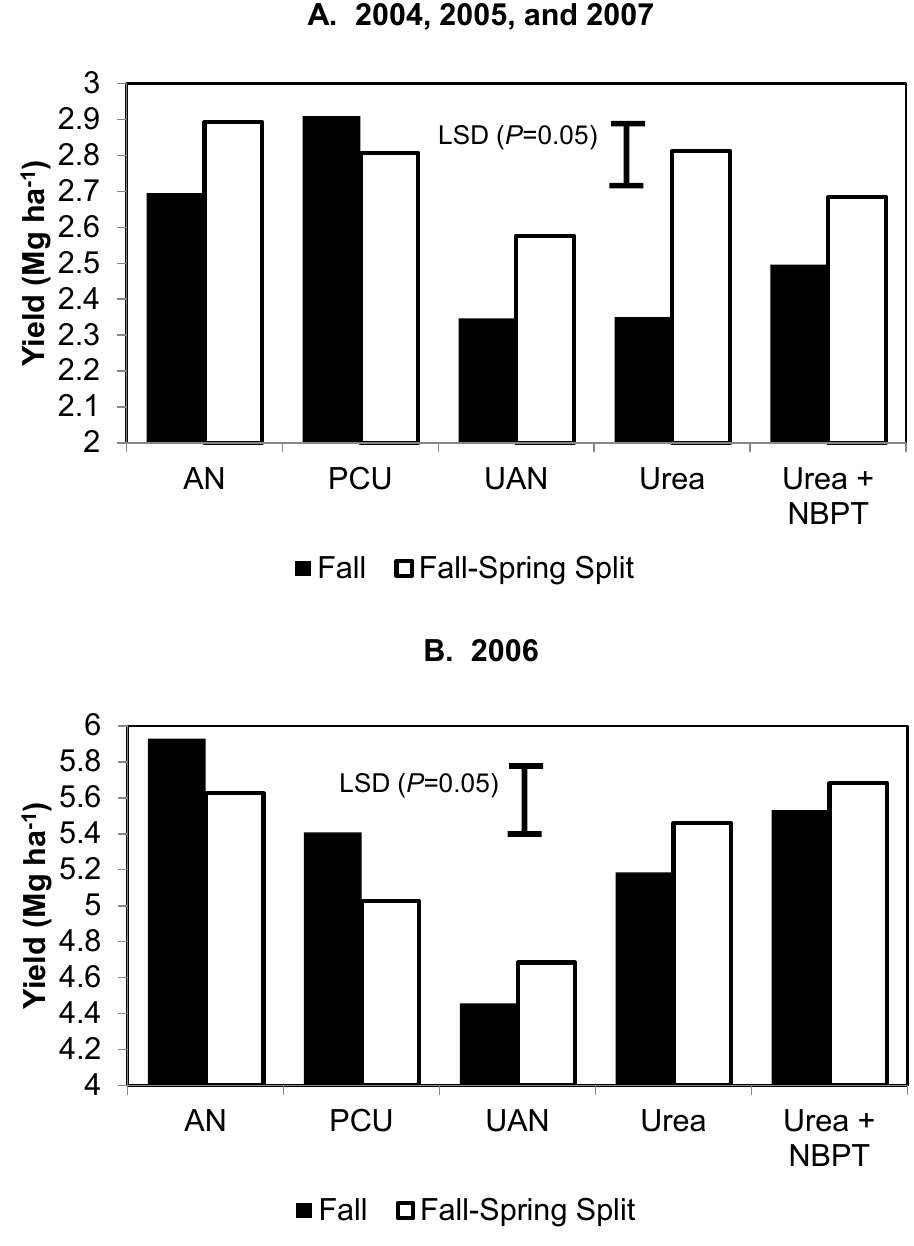
Figure 3. Wheat grain yield response to fall (112 kg N ha − 1 ) and fall-spring (28 kg N ha − 1 in the fall and 84 kg N ha − 1 in the spring) split applied nitrogen sources (AN, ammonium nitrate; PCU, polymer-coated urea; UAN, urea ammonium nitrate; urea; and urea plus NBPT in 2004, 2005, and 2007 (top) and 2006 (bottom). LSD ( p = 0.05) is 0.19 Mg ha − 1 for the top figure A (data were combined over 2004, 2005, and 2007) and 0.39 Mg ha − 1 for the bottom figure B